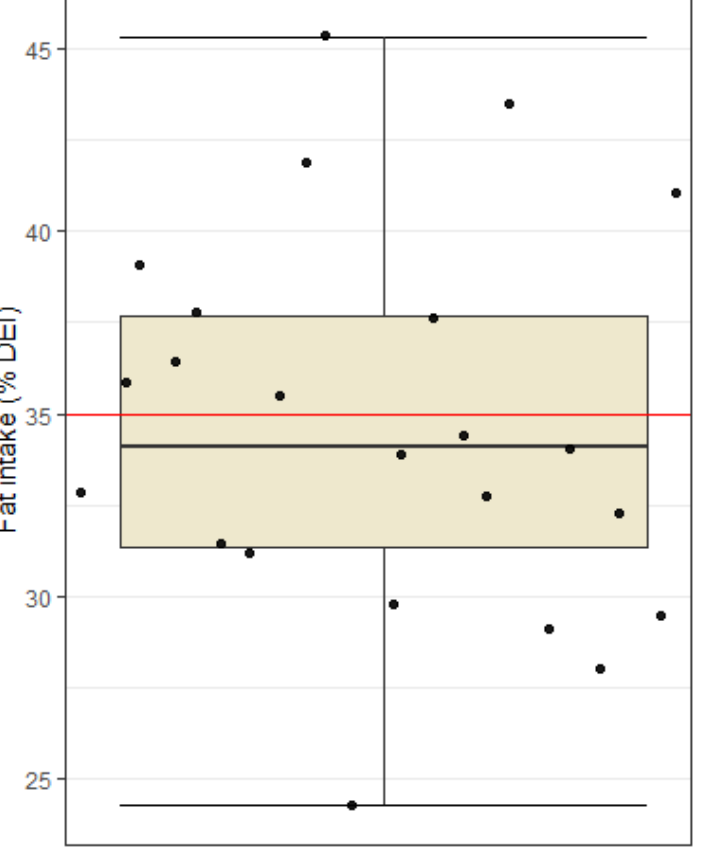
Figure 4. Fat intake among football players. Dots represent individual participants ( n = 23). Red line indicates upper limit of recommended intake (35% of daily energy intake).